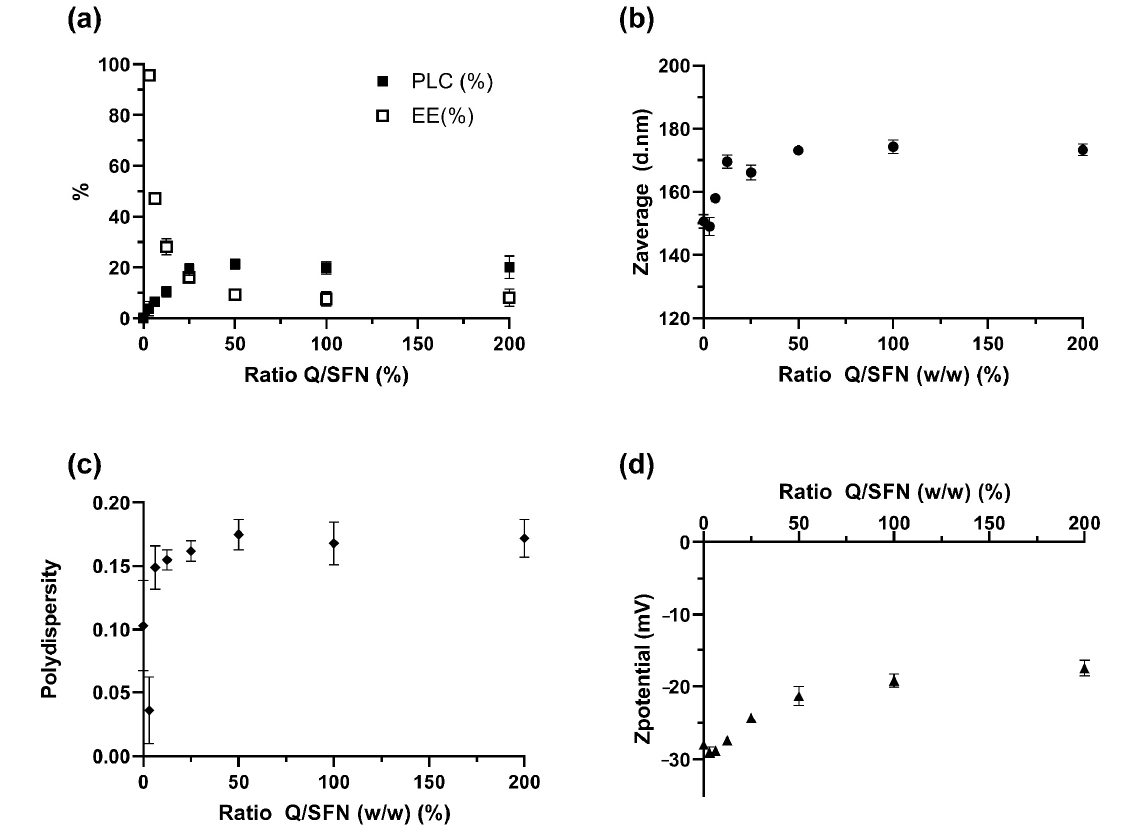
Figure 3. Effect of loading ratio Q/SFN in the PPh loading performance ( a ) and the hydrodynamic characteristics of the loaded nanoparticles ( b – d ).